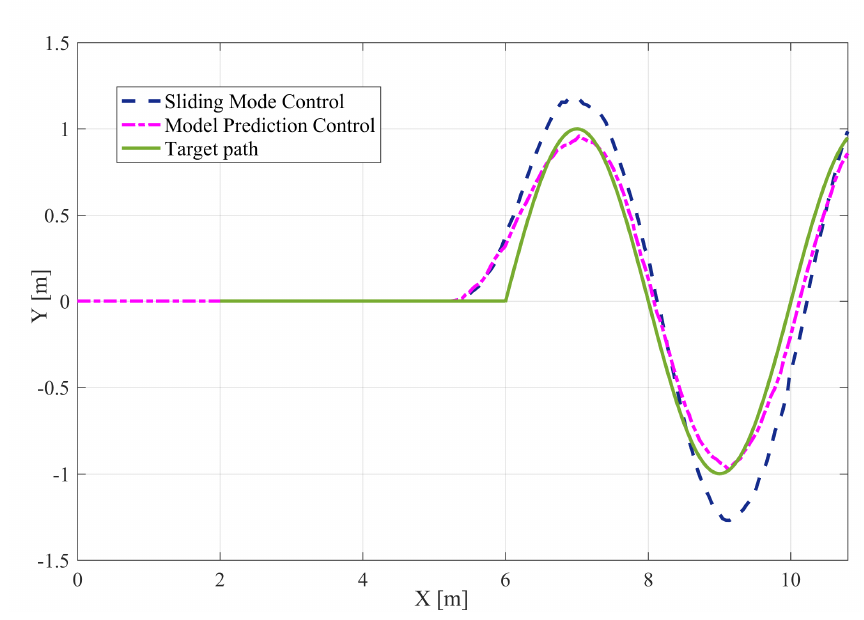
Figure 15. Tracking performance of MPC and